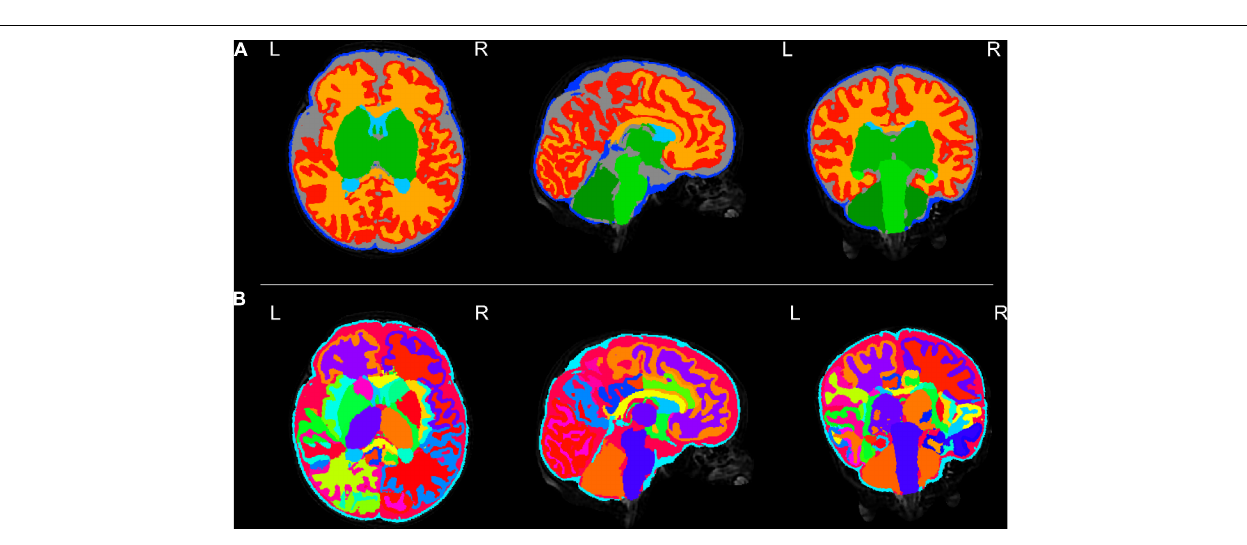
FIGURE 4 | Tissue segmentation and neonatal atlas parcelation for the same infant. Using the automated dHCP structural pipeline, the anatomical images can be segmented into nine tissue classes ( A: top row) and parcellated into 87 brain regions ( B: bottom